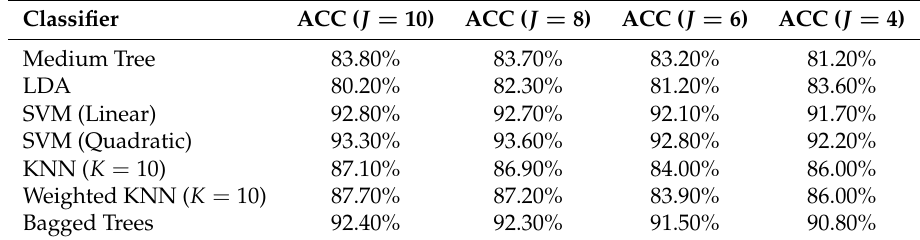
Table 5. Classification accuracy comparison of using different classifiers with both basic and wavelet features (for wavelet features, with varying J